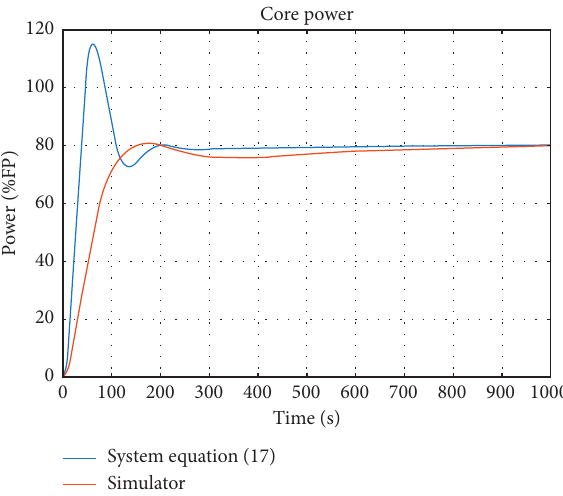
Figure 7: Power level response of linear model equation (11) and CPR1000